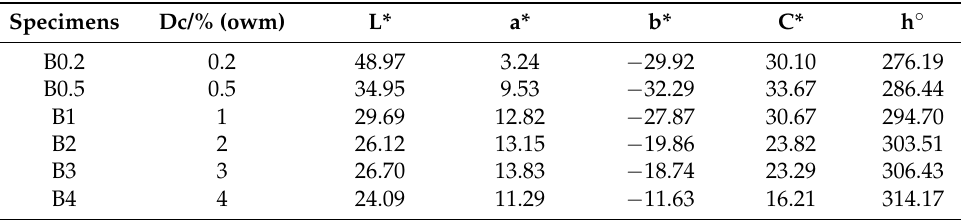
For blue specimen, the color characteristics show decreases in chroma (C*) as the color concentration increases, which is characteristic for the blue hue. The lightness value (L*) also decreases significantly with increasing dye concentration. A significant change in hue (h ◦ ) was obtained with increasing dye concentration. The hue changes from blue (h ◦ = 276.19 for dye concentration 0.2%) to violet (h ◦ = 314.17 for dye concentration 4%). The remission curves confirm the change in spectral characteristics of the color with a Molecules 2021 , 26 , x FOR PEER REVIEW 2 of 15 B1